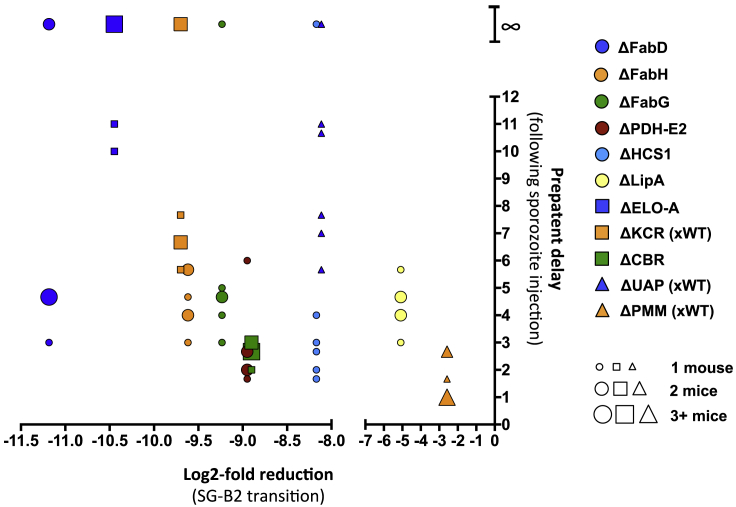
A Graph Showing Correlation between the SG-B2 Transition Phenotype Seen in the M-L Screen and In Vivo Data for Single Gene Knockout Parasite Lines, Related to Figures 5, 6, and 7The prepatent delay in the appearance of blood stage infection following injection of sporozoites is shown for each mouse injected with single gene knockout parasite lines ΔFabD, ΔFabH, ΔFabG, ΔPDH-E2, ΔHCS1, ΔLipA, ΔELO-A, ΔKCR (xWT), ΔCBR, ΔUAP (xWT) and ΔPMM (xWT) in relation to the log2-fold reductions at the SG-B2 transition in the M-L screen. The sizes of data point indicate the number of mice (total of 6) that show each pre-patent period. The ∞ symbol indicates mice that never became positive after sporozoite injection.